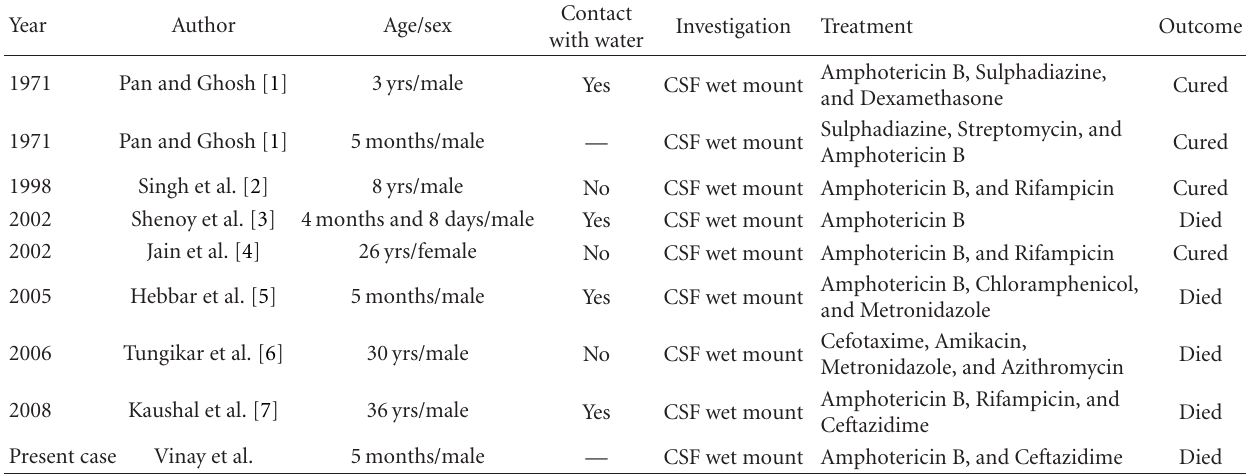
Table 1: Indian cases of Naegleria fowleri meningitis.